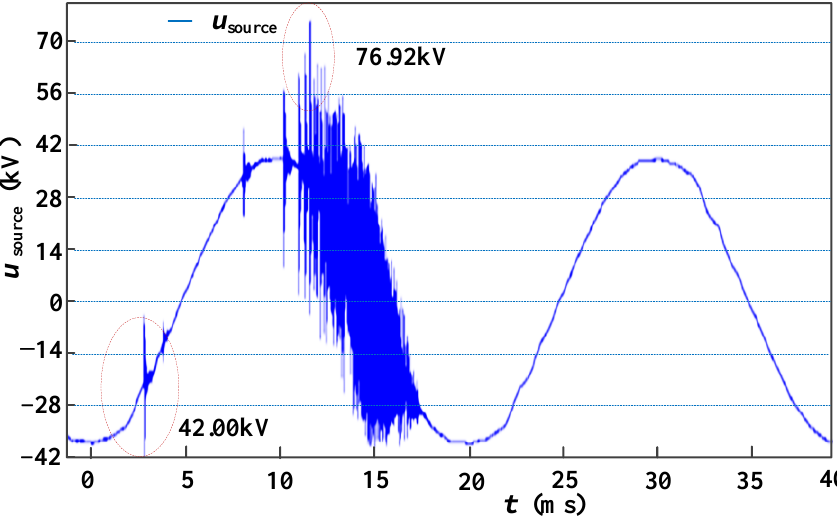
Figure 17. Operating overvoltage in the closing process when the phase angle is −65° . Figure 18 shows the relationship between the closed phase angle and the overvolt- age amplitude. As the closed phase angle increases, the overvoltage amplitude increases. When the voltage peak is closed, the overvoltage amplitude is the highest.